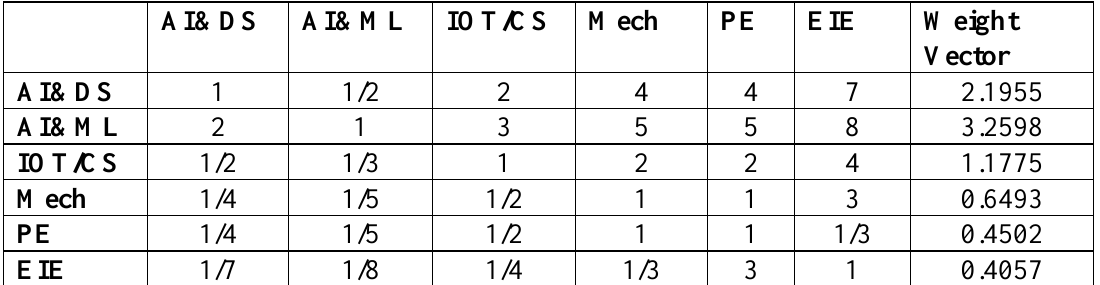
(Higher pay package) 3